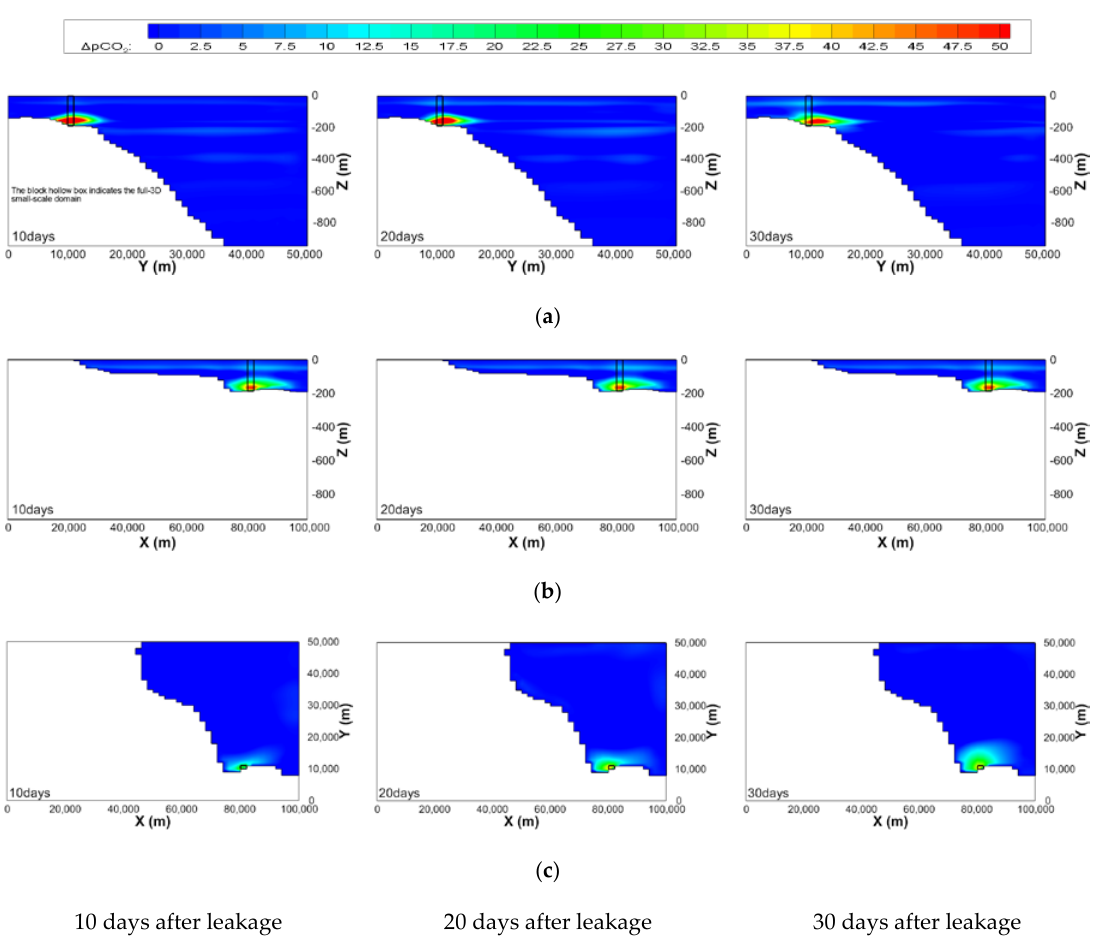
10 Figure 10. Time change of contour maps of ∆ pCO 2 on the planes, where the full-3D small-scale domain is located, of the mesoscale domain for case 3 (leakage rate = 100,000 t / y). ( a ) yz plane (x = 81,000 m); ( b ) zx plane (y = 10,500 m); ( c ) xy plane (z = 180 m) 4.2. E ff ect of Initial Diameter of CO 2 Bubble (Cases 5, 4, and 3 / Leakage Rate = 100,000 t / y, Leakage Area = 20,000